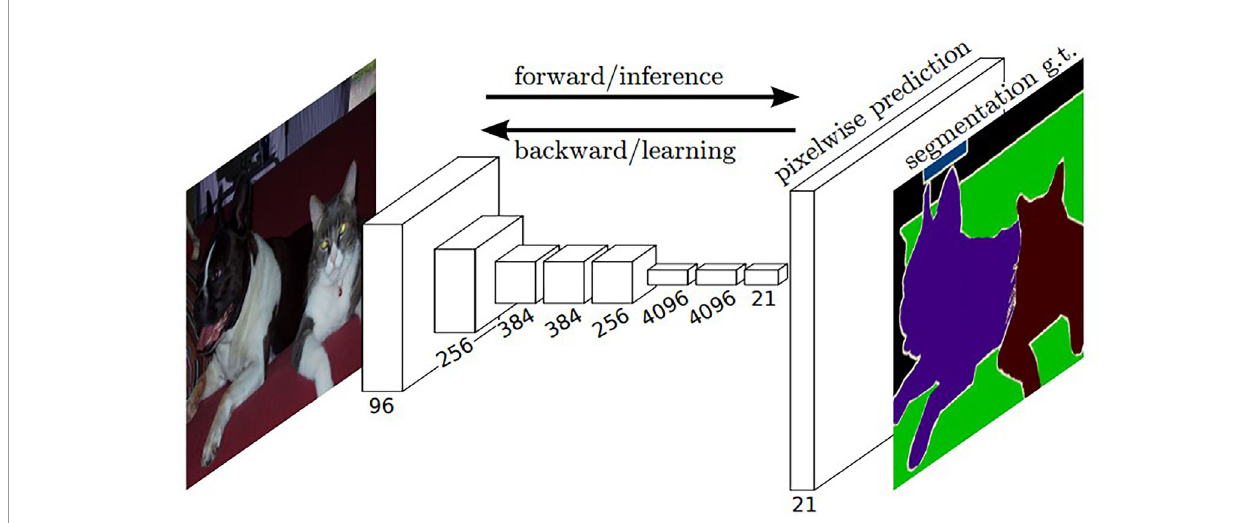
FIGURE 2 | Architecture of a typical FCN (45). The white boxes represent multi-channel feature maps after the convolutional operation.